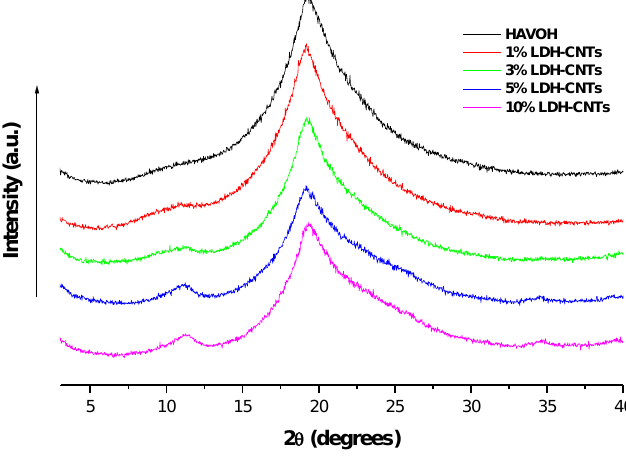
Figure 5. XRD spectra of HVOH and all the composites.